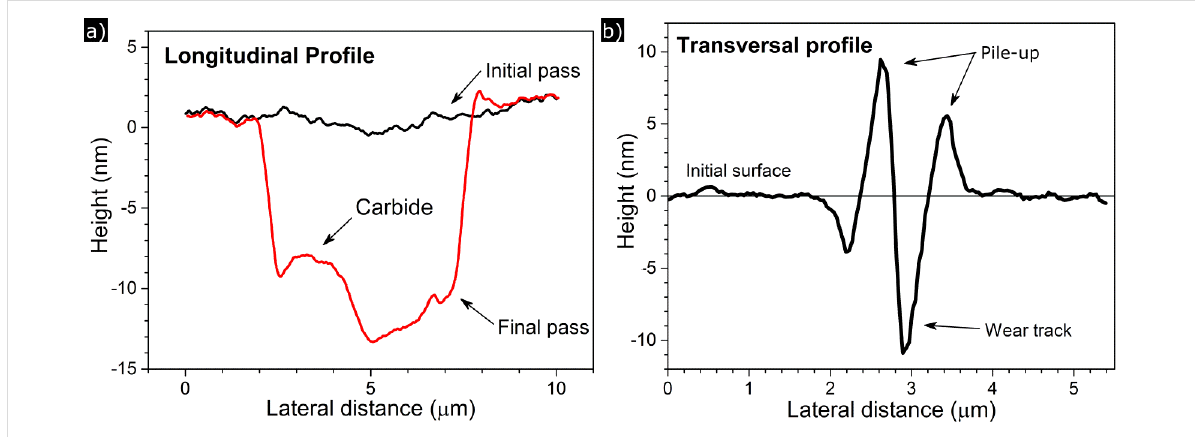
Figure 9: Depth profiles after a wear test in a DCT specimen in the a) longitudinal and b) transversal directions. The formation of the wear groove and the pile-ups around the track can be seen, as well as the probable revelation of a subsuperficial